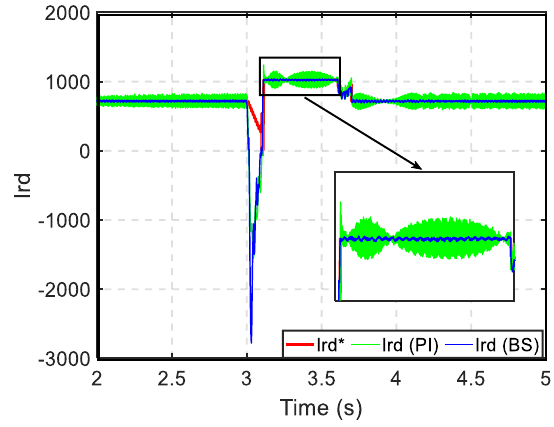
Fig. 21 Reactive ird current